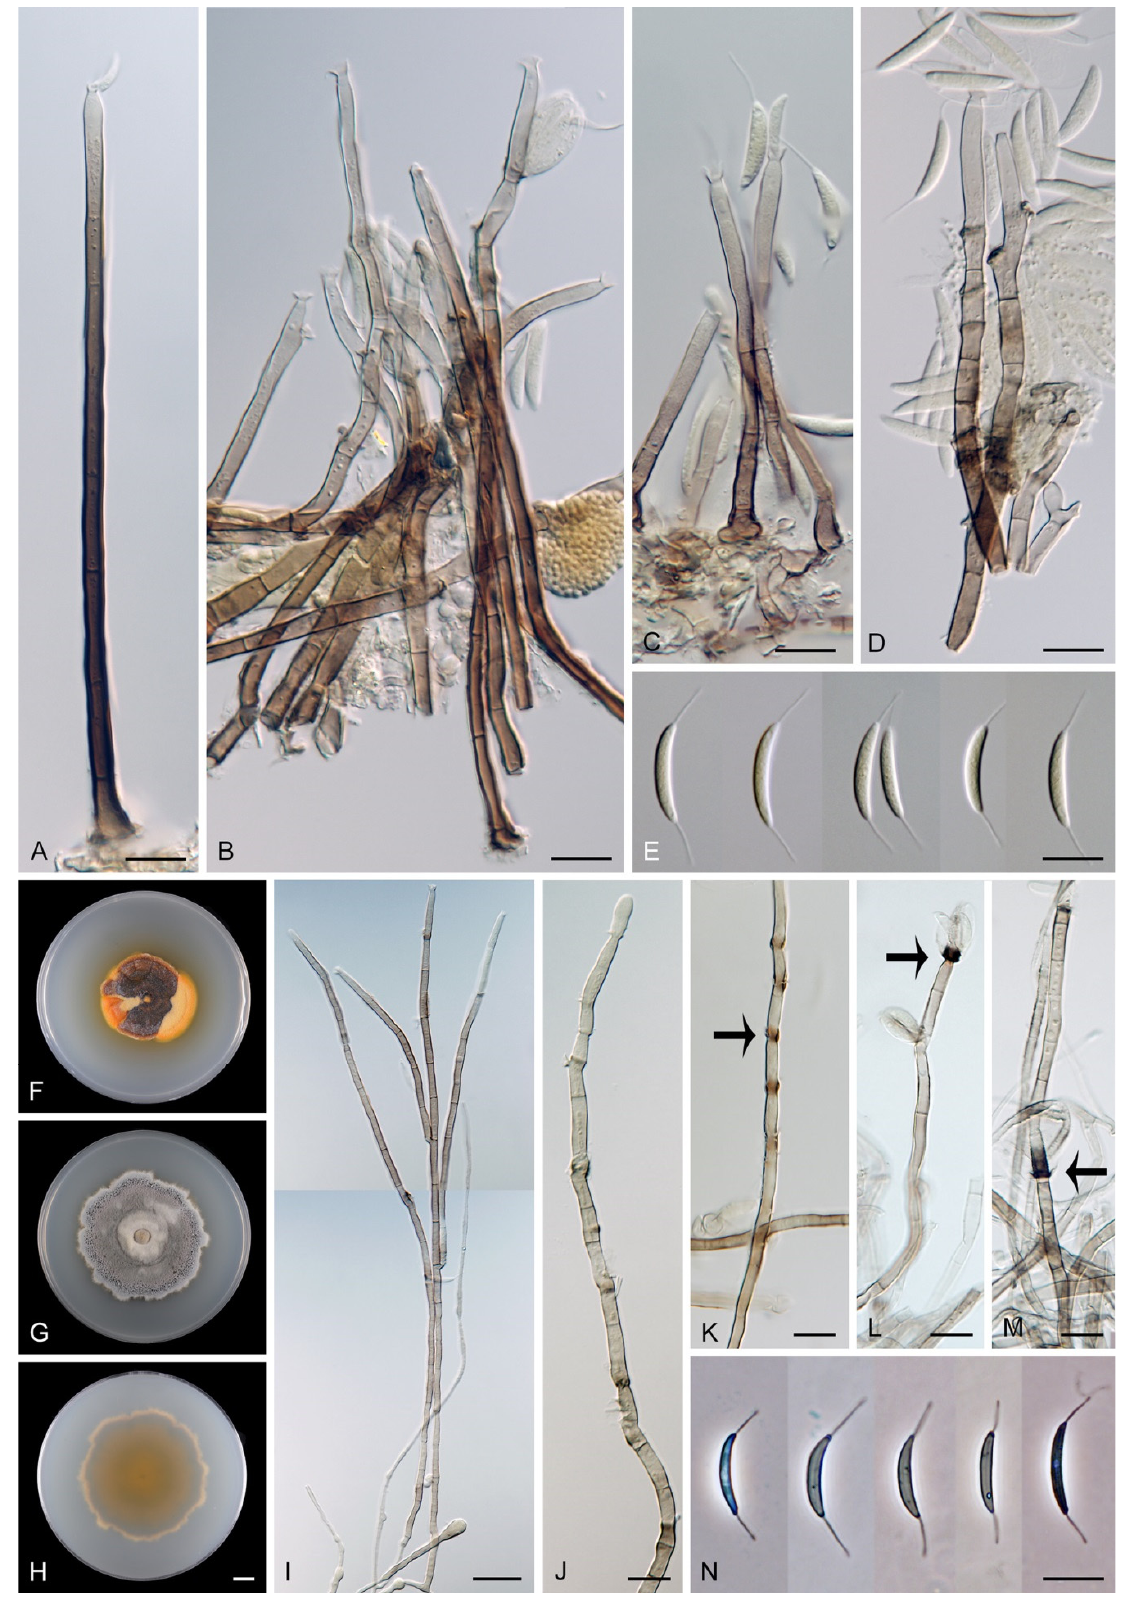
Figure 27. Codinaeella minuta . ( A – D , I – M ) Conidiophores ( E , N ) conidia ( F – H ) colonies. Images: ( A – E ) from nature ( F – H ) on MLA after 4 weeks ( I – N ) on a stem of U. dioica on CMA after 4–8 week ( A – E ) from CBS 145099 ( F ) from CBS 146619 ( G , H , L , M ) from DAOM 148141 ( I – K , N ) from CBS 146619. Scale bars: ( A – E , J – N ) 10 μ m; ( F – H ) 1 cm; ( I ) 20 μ m.